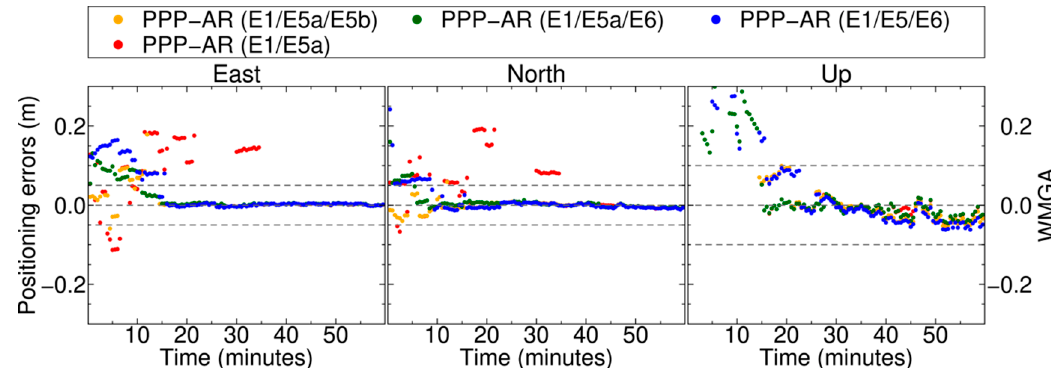
Figure 7. East, north, and up components of 1 h positioning errors (m) at Station WMGA on day 121, 2019. The solutions of dual-frequency (E1/E5a) and triple-frequency (E1/E5a/E5b, E1/E5a/E6, and E1/E5/E6) PPP-AR with the pilot Galileo receiver antenna corrections are shown in different colors. The horizontal dashed lines represent the convergence regions.